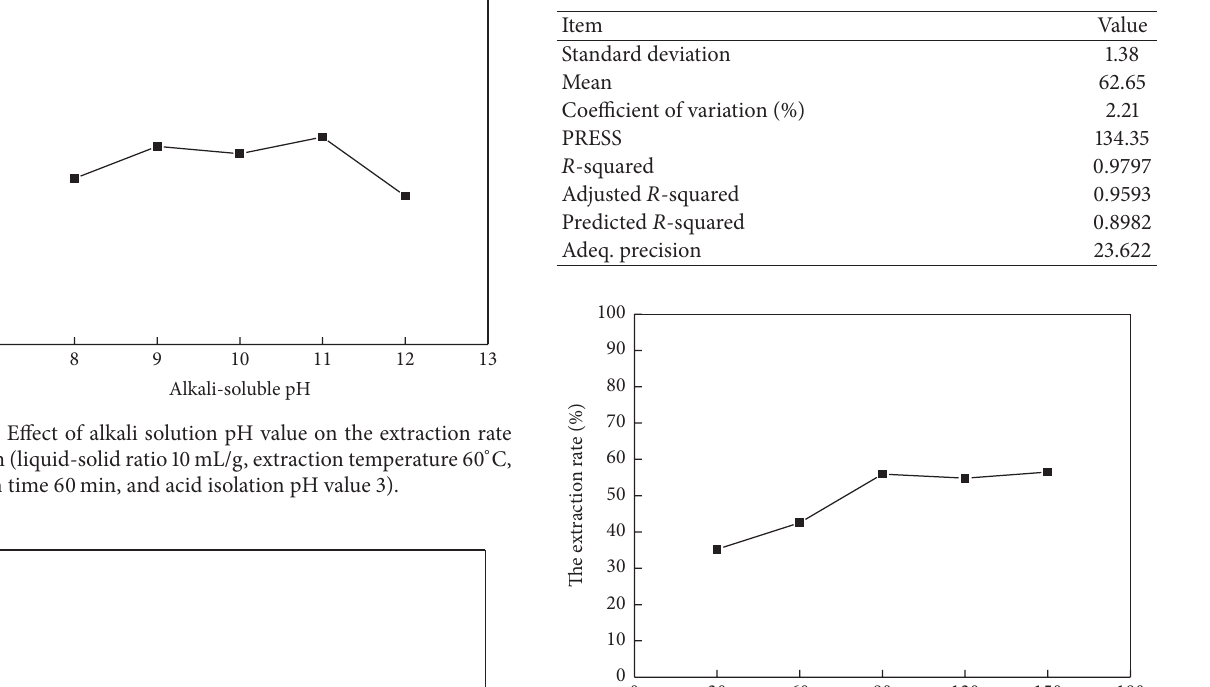
Table 4: Analysis of model reliability.